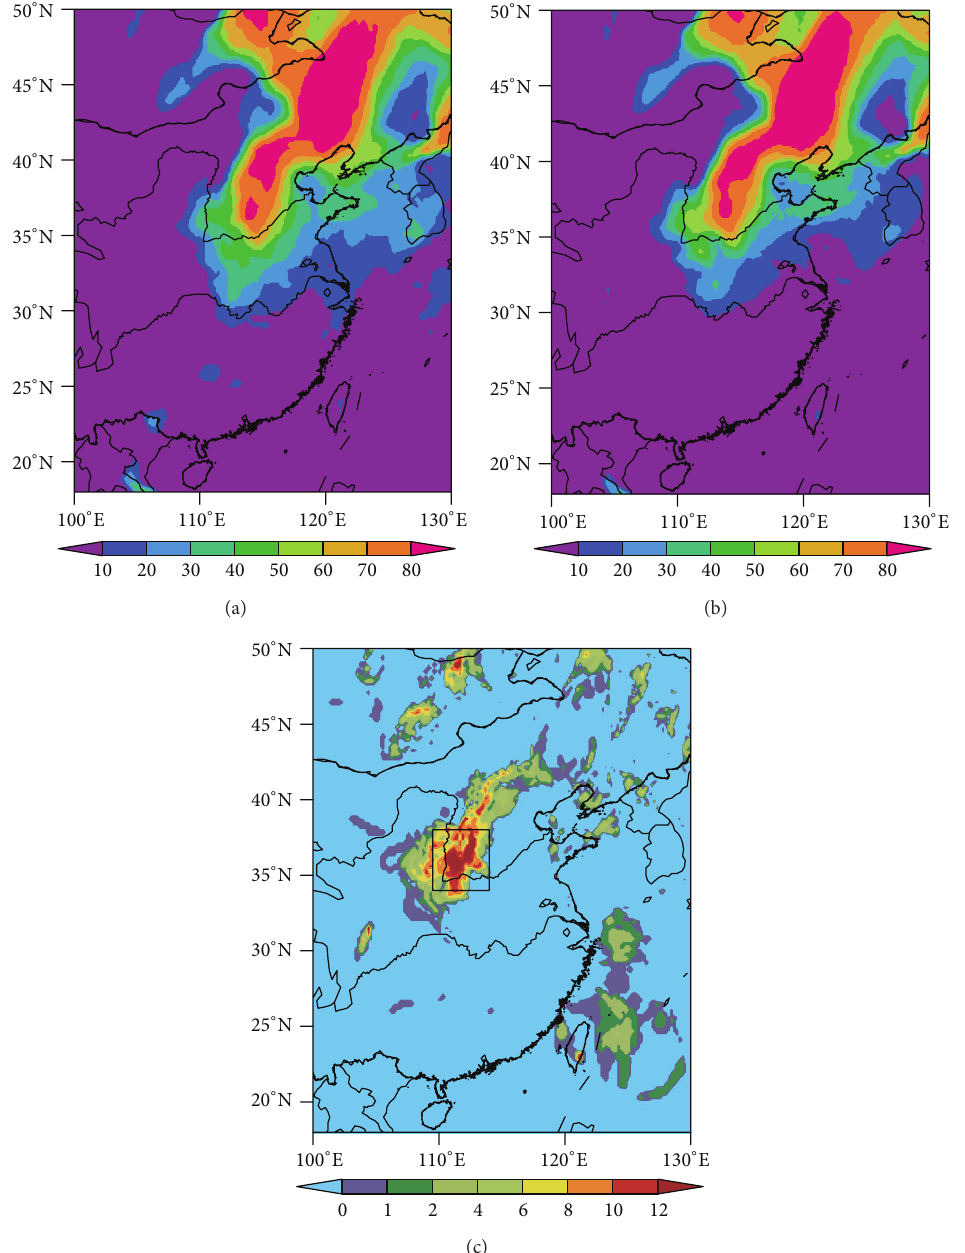
Figure 9: The simulated cold surge frequency in winter for the (a) Nodust and (b) Dust experiments and (c) the differences (Dust minus Nodust) averaged in winter during the 2000–2009 period. The box region will be used to compare the differences between Dust and Nodust